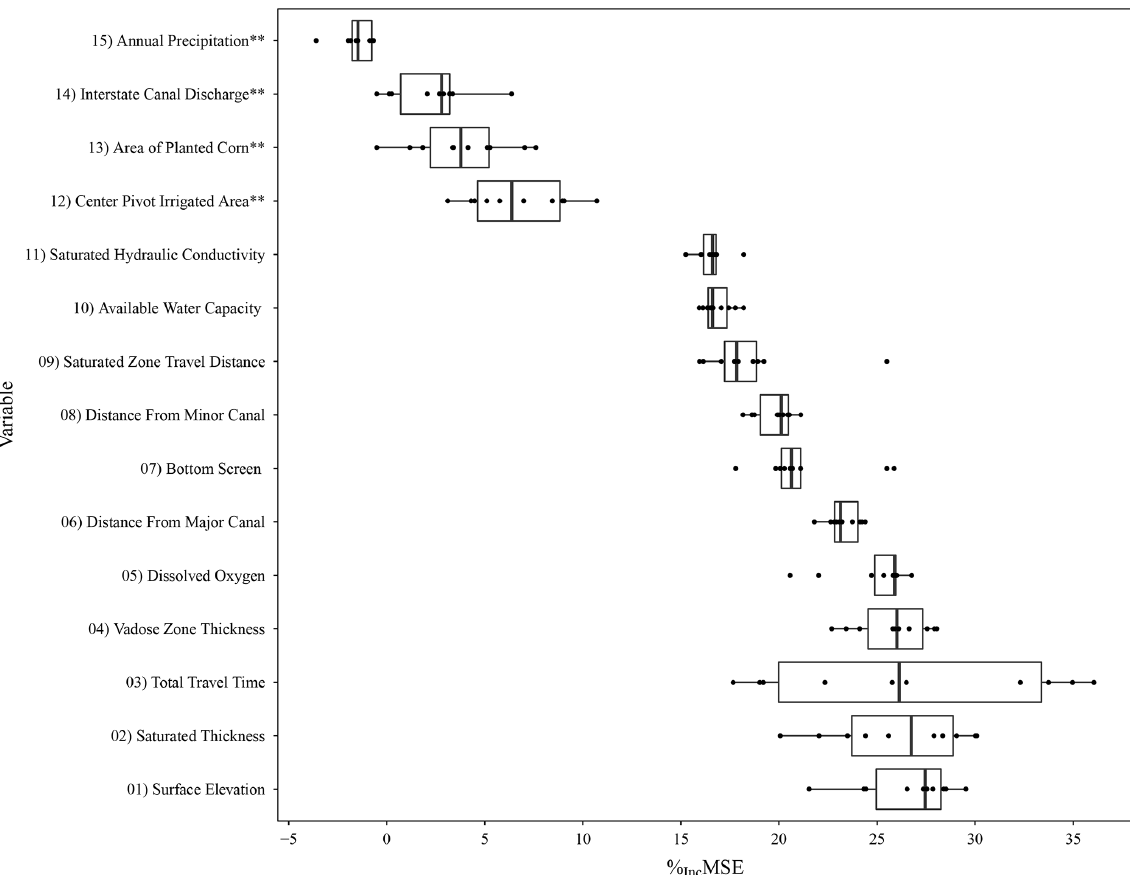
Figure 5. Box plot of the % inc MSE from the 10 transport rate combinations shown in Table 2. Each box plot has 10 points for each transport rate combination, representing the median % inc MSE from the 25 models (five-fold cross validation repeated five times). A larger % inc MSE suggests that the variable had a greater influence on a model’s ability to predict NO − s . Note: ∗∗ denotes dynamic predictors.